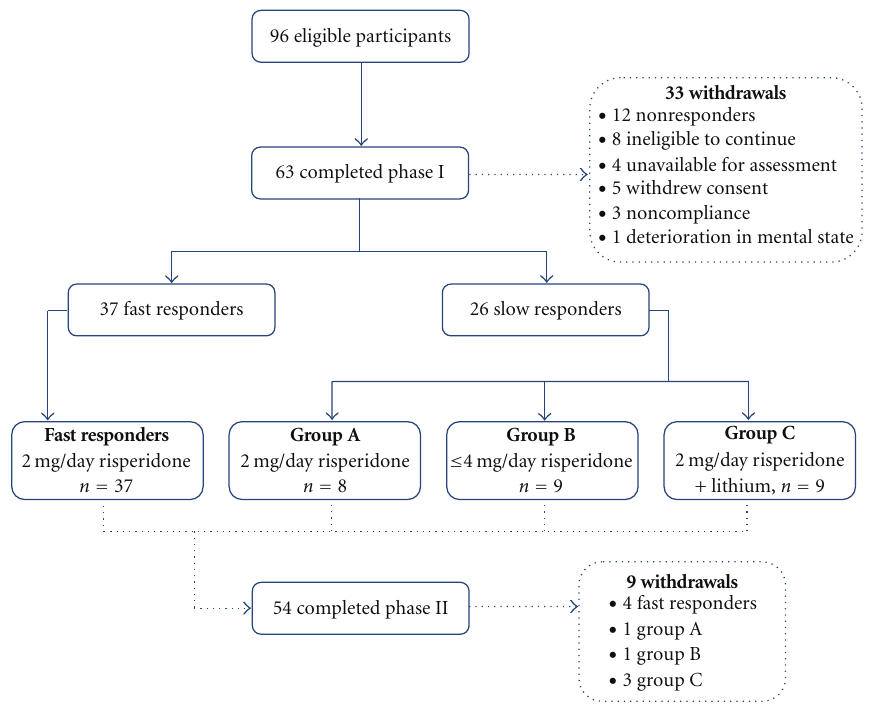
Figure 2: Disposition of patients over phases I and II of the study.